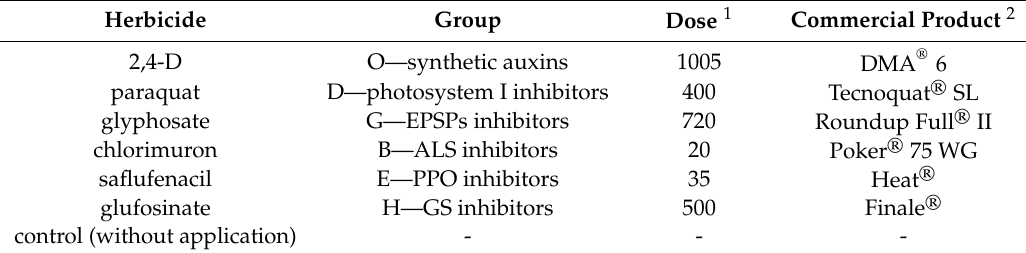
Table 2. Herbicides applied to C. sumatrensis plants for each site. Herbicide Group Dose 1 Commercial Product 2 2,4-D O—synthetic auxins 1005 paraquat glyphosate chlorimuron E—PPO inhibitors glufosinate H—GS inhibitors 500 Finale ® control (without application) - -